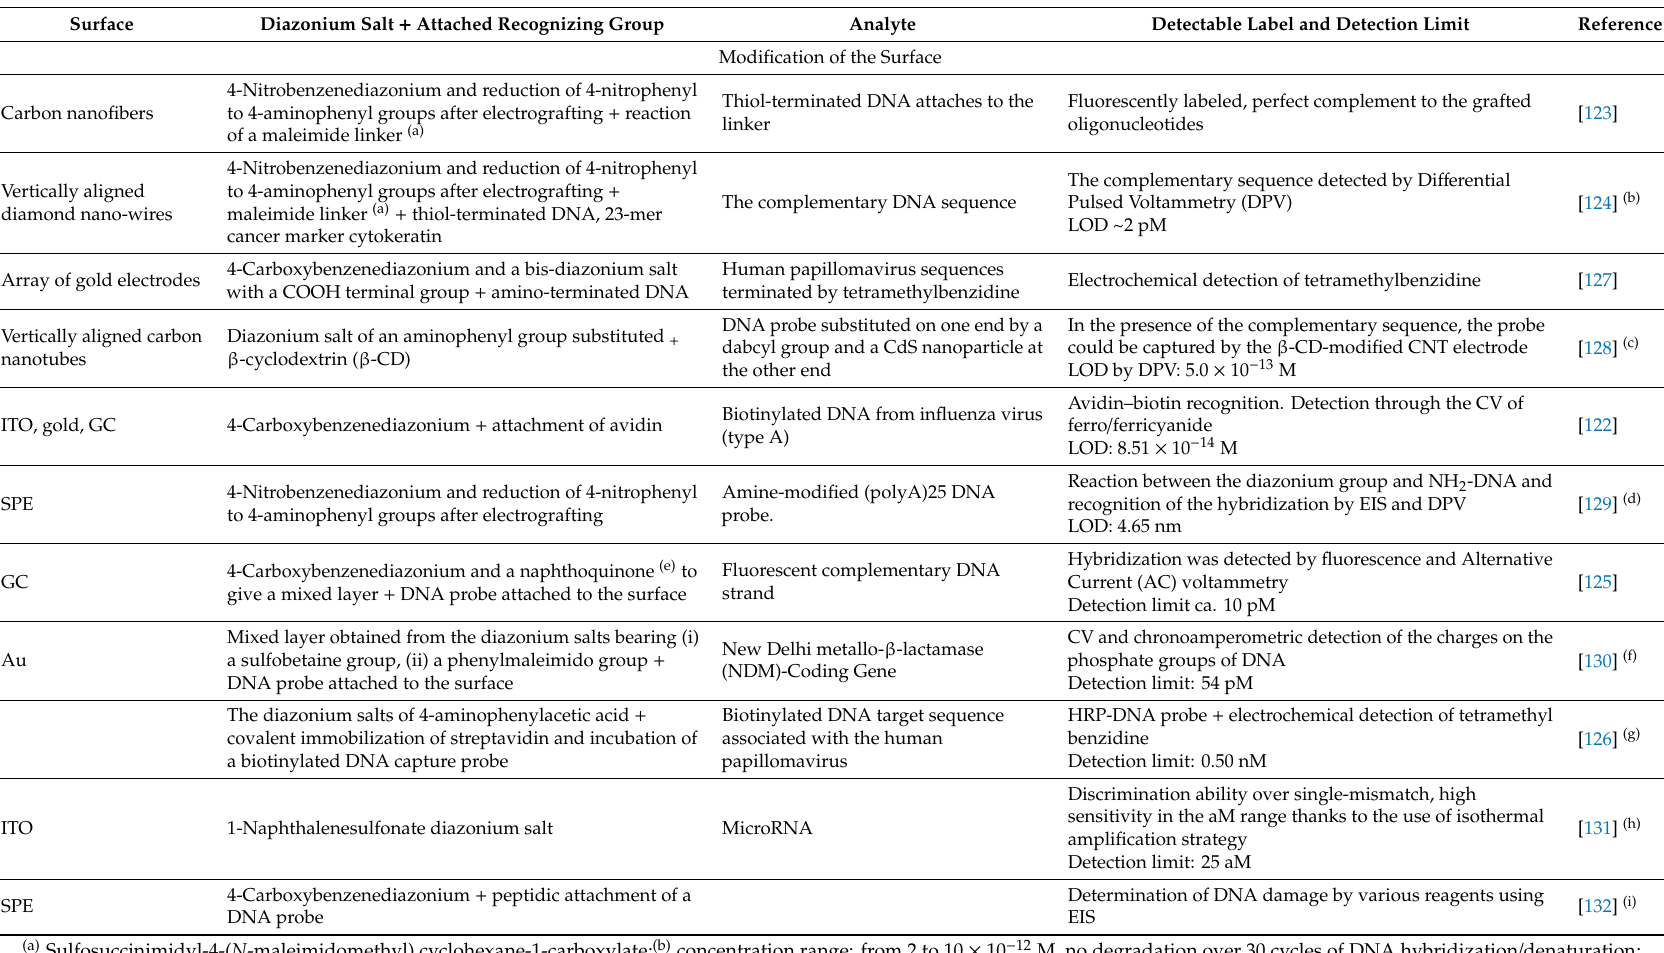
Table 5. Detection of